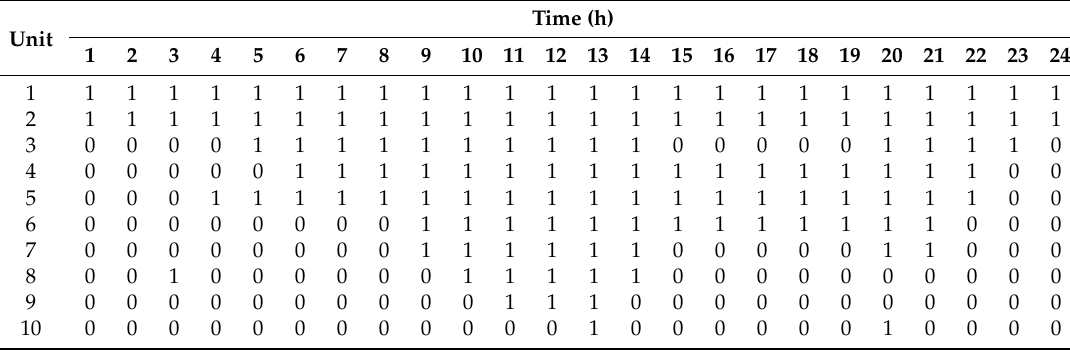
Table A4. Unit State Combination of